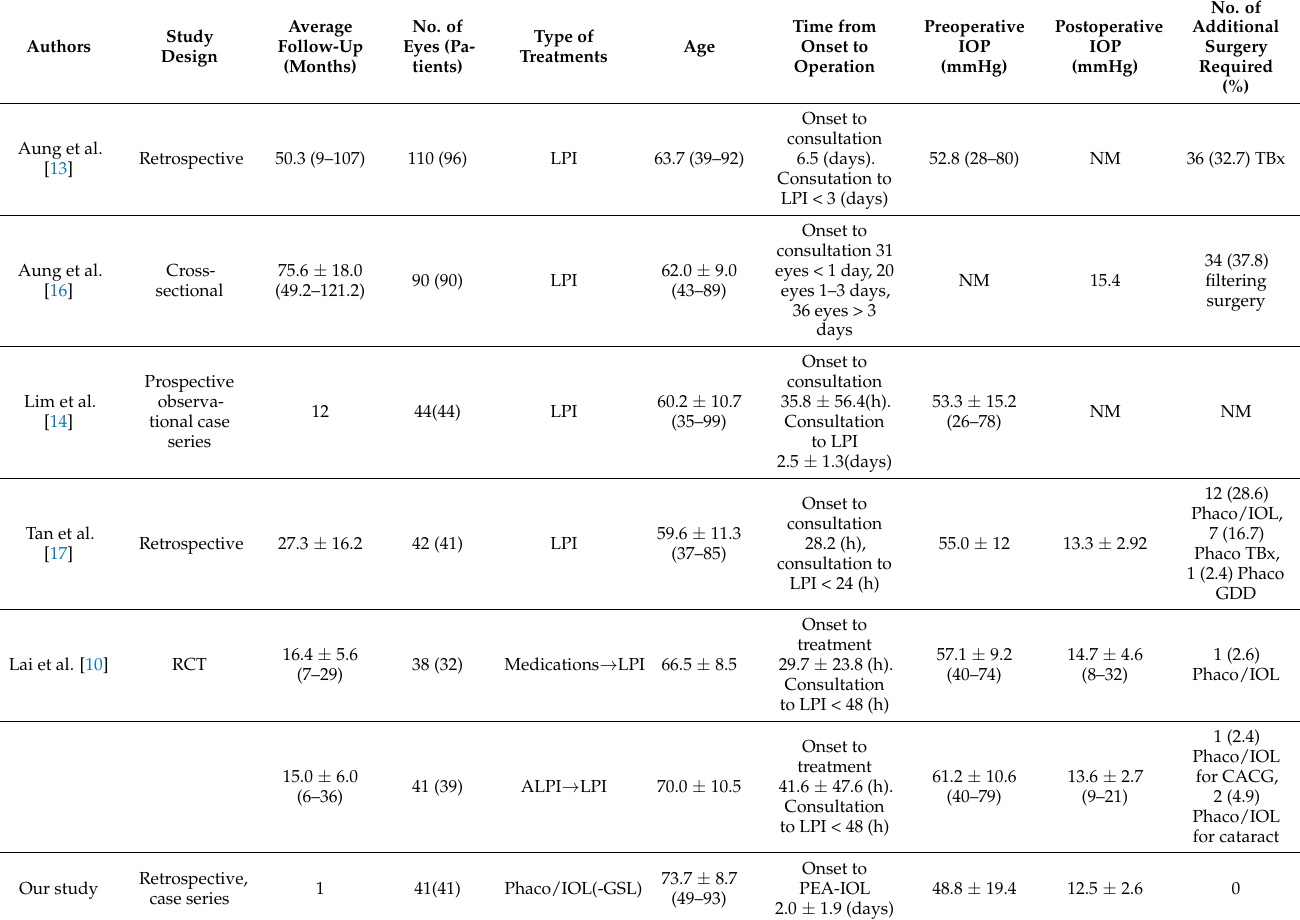
Table 6. Comparison between previous reports about LPI and our